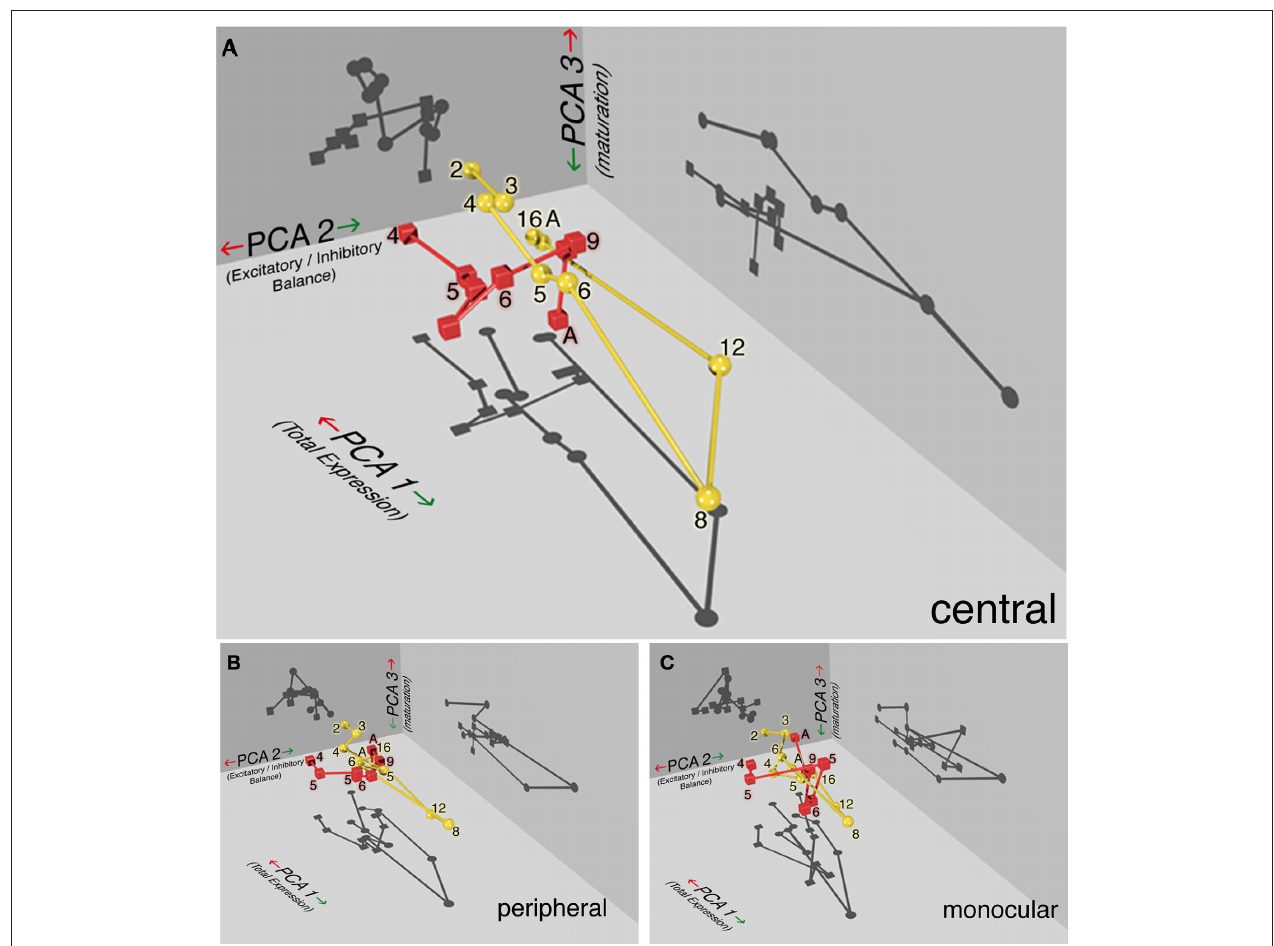
captures the maturation of receptor composition. The developmental trajectory for normal animals (yellow sphere, circle shadows) can be described as a slowly descending curved staircase that traversed a long direction of increasing expression (PCA 1) and slow maturation of receptor subunits (PCA 3) between 2 and 8 weeks of age followed by turning a corner to a new E/I balance (PCA 2) at 12 weeks and pruning back the total receptor expression by 16 weeks. The trajectory for deprived kittens (red cubes, square shadows) was shifted on all three dimensions and truncated from the normal pattern. The difference between normal and deprived kittens was greatest for the (A) central visual field and less for the (B) peripheral and (C) monocular